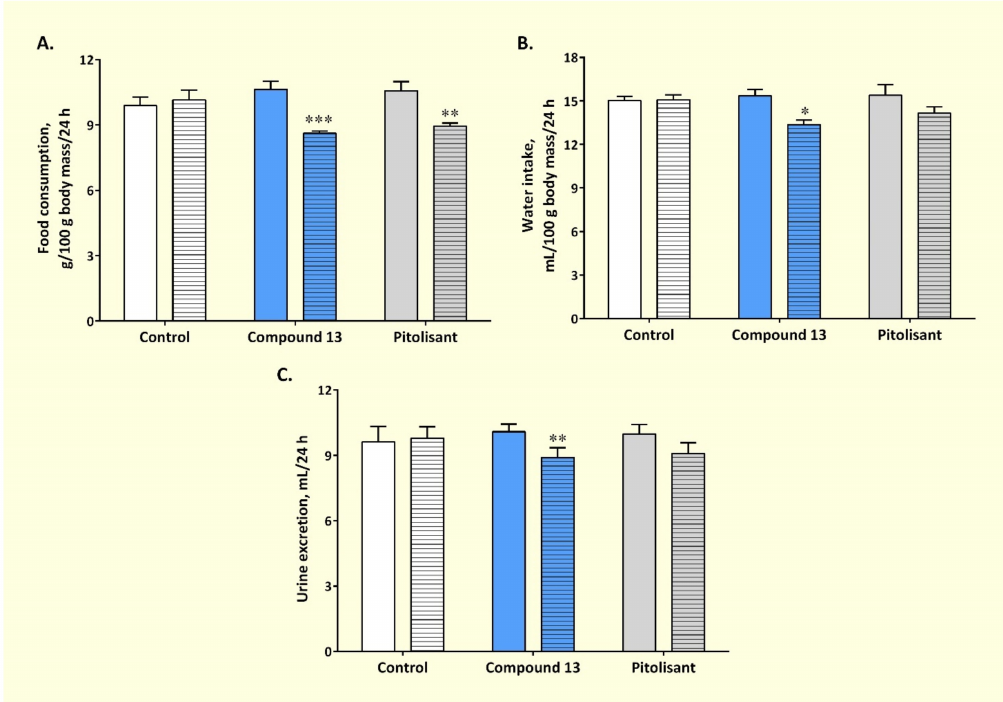
Figure 7. The effect of sub-chronic administration of the compound 13 on food ( A ) and water ( B ) consumption, and urine output ( C ). Pitolisant, a histamine H 3 receptor antagonist/inverse agonist, was employed as the reference compound. The tested compounds (both in a dose of 3 mg/kg of body mass) were injected subcutaneously for 6 consecutive days. The values are mean ± SEM. The bars without a pattern correspond to the 3-day pre-test monitoring, whereas bars with pattern correspond to the 6-day treatment period with appropriate drugs. Paired t -test: * p < 0.05, ** p < 0.01 or *** p < 0.001 vs. pre-test (i.e., before